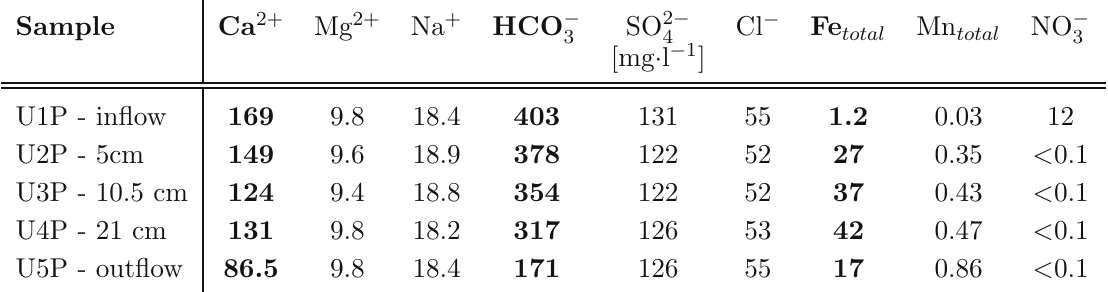
Table 4 Representative concentrations of dissolved inorganic